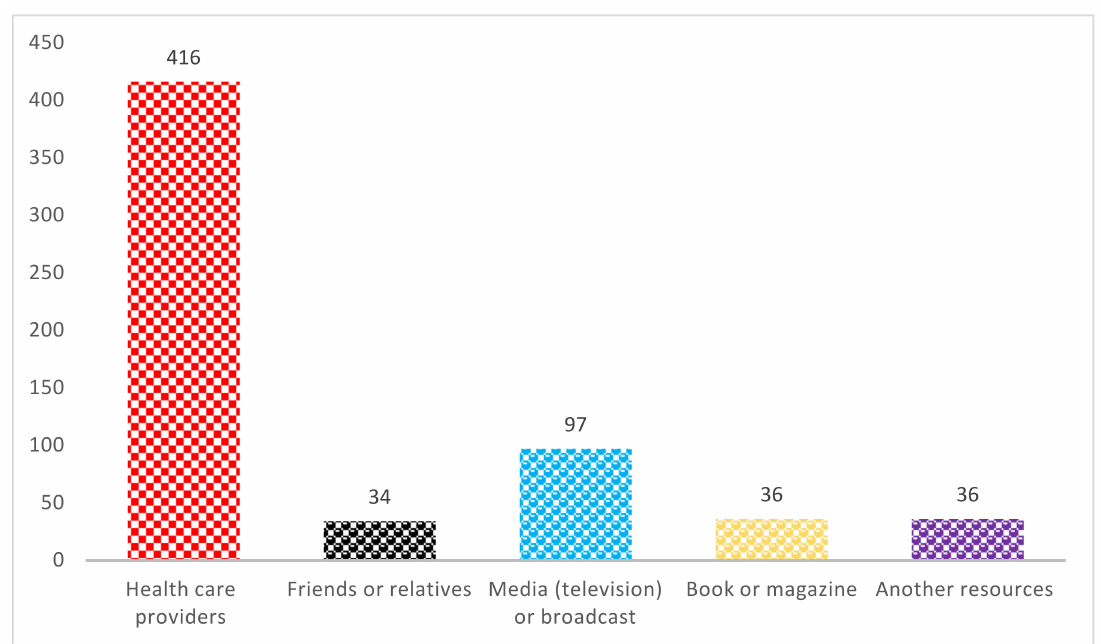
Figure 1. Source of knowledge of FA among participants.